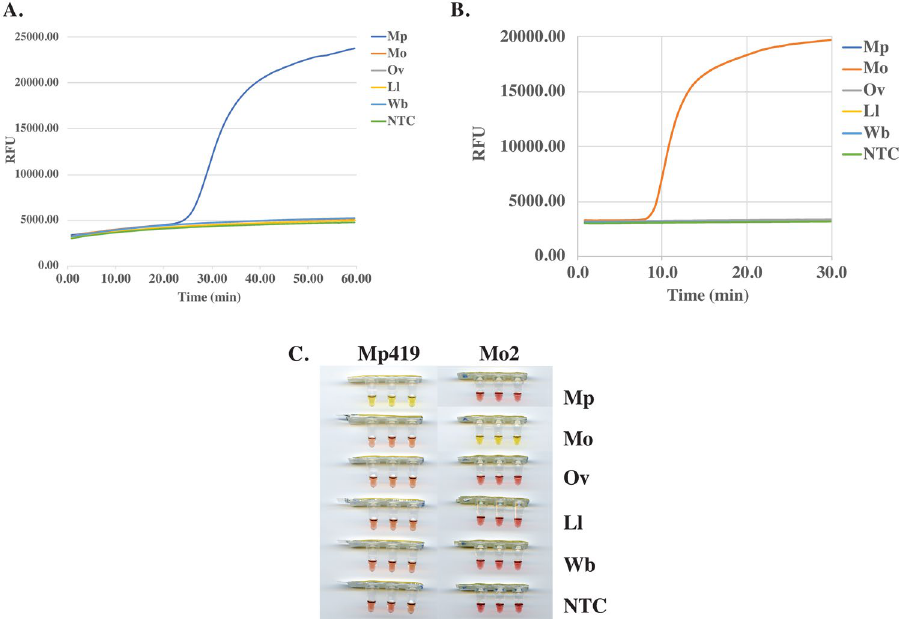
Figure 5. Species-specificity of the Mansonella LAMP assays. Reactions containing DNA (100 pg) from M . perstans (Mp), M . ozzardi (Mo), O . volvulus (Ov), L . loa (Ll) or W . bancrofti (Wb), and either the M . perstans or M . ozzardi LAMP primers were performed in colorimetric master mix containing a fluorescent dsDNA binding dye. DNA amplification was monitored in real time using a qPCR machine. The real time amplification curves for the Mp419 ( A ) and Mo2 ( B ), as well as the end-point color change of the LAMP reactions ( C ) are shown. Water was substituted for DNA in the non-template controls